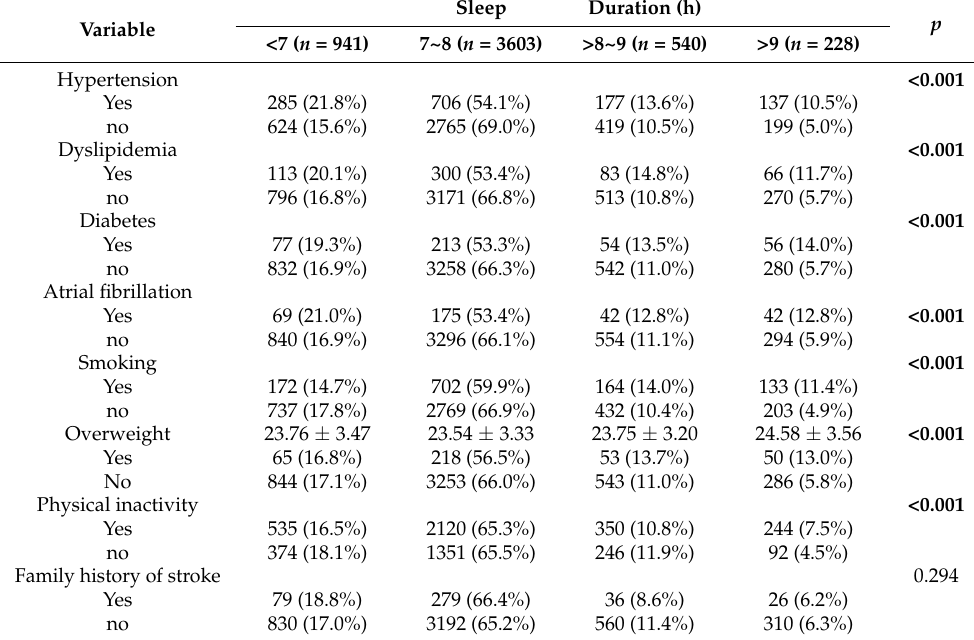
Table 2. Stroke risk factors across categories of average sleep duration.